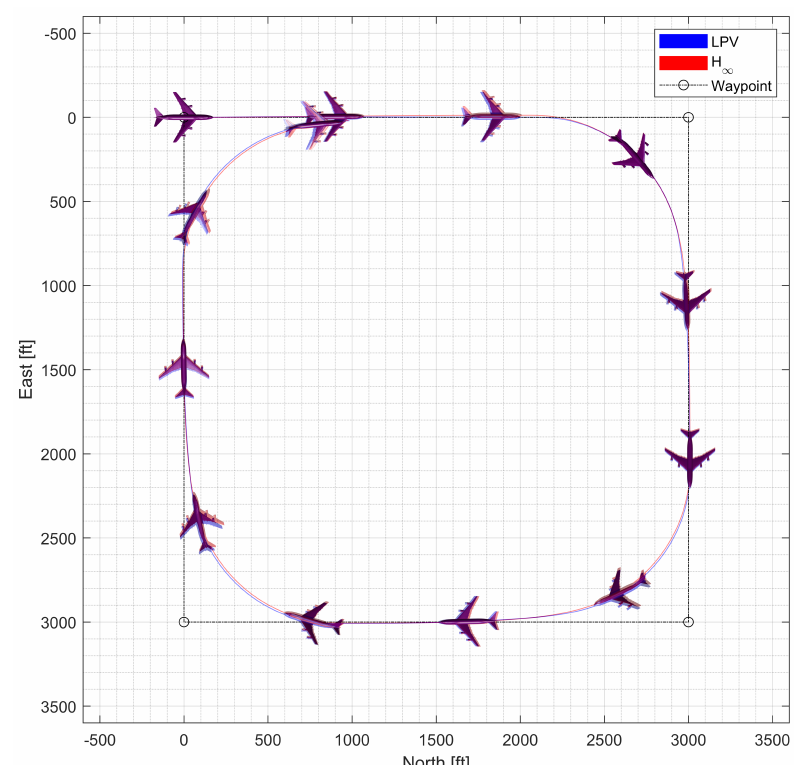
Figure 20. Flight trajectory of the waypoint-following